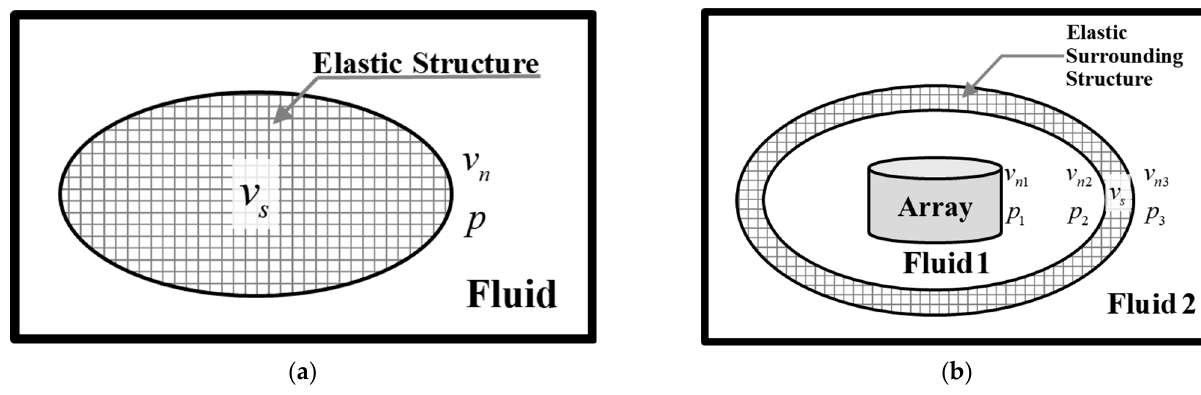
Figure 3. Schematic diagram of a model with fluid-structure interaction: ( a ) an elastic structure immersed in an acoustic medium and ( b ) the radiating surface of the array and its elastic surrounding structure.